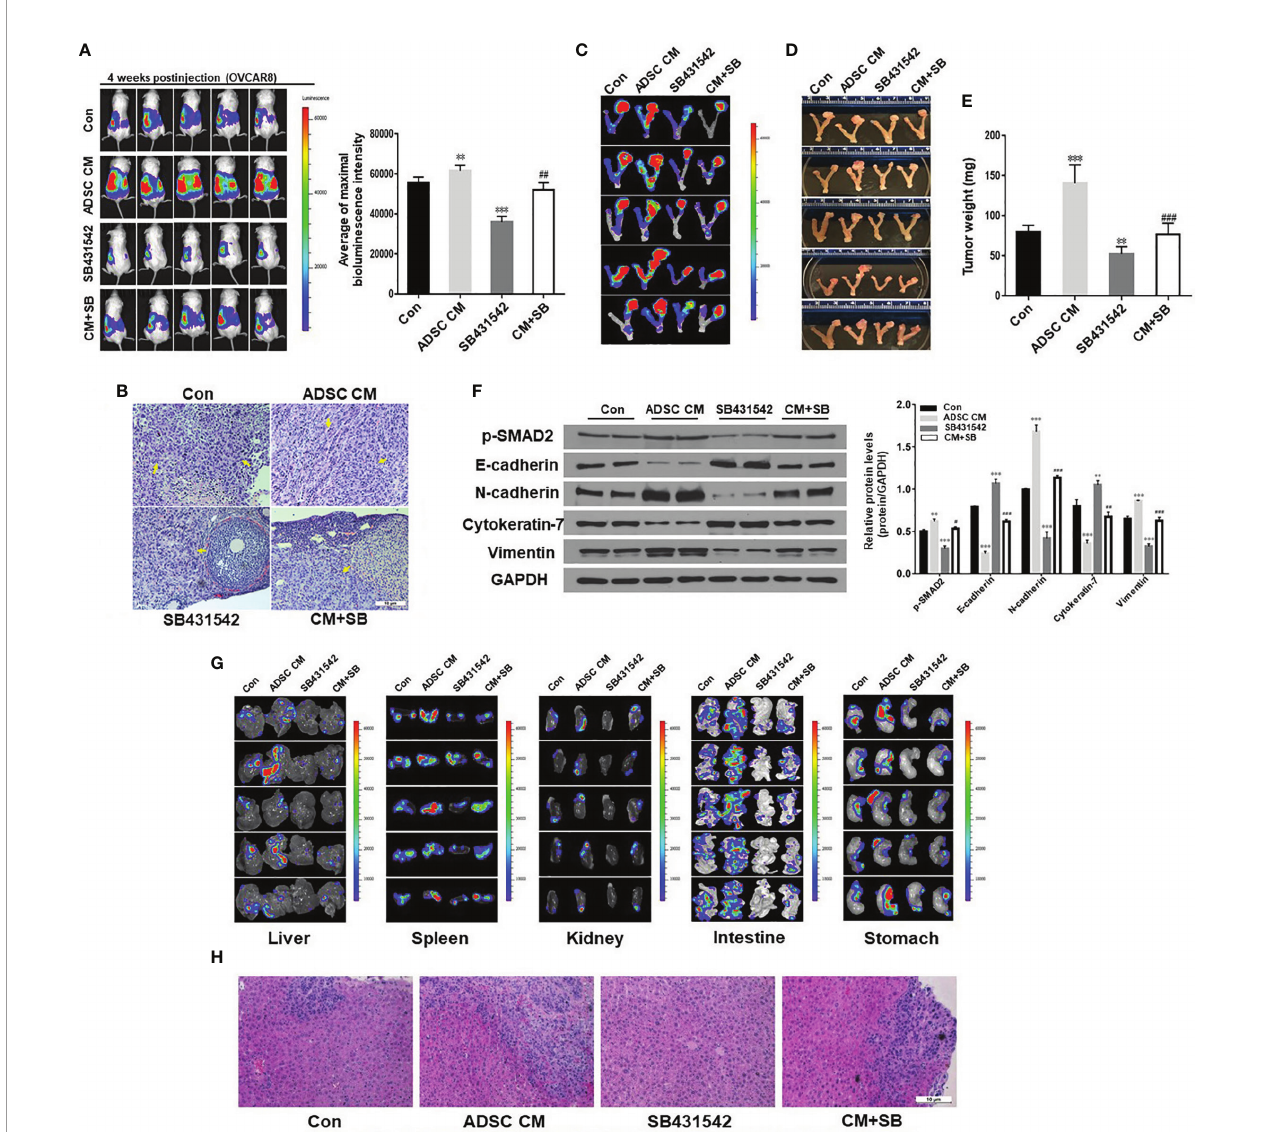
FIGURE 4 | ADSC enhance primary ovarian tumor growth and metastasis in an orthotopic ovarian cancer mouse model. (A) Live animal imaging of primary tumors in ovaries of mice at 4 weeks following intrabursal injection of OVCAR8 cells. Right, the quantitative bioluminescence intensities. (B) H&E staining of primary tumor in ovaries. There are high-grade serous carcinomas involving the ovarian stroma. No normal ovary structure could be seen in the control and ADSC-CM groups. Tumors are indicated by yellow arrows. (C) Primary tumors in ovaries of mice were identi fi ed by live animal imaging. (D, E) Tumors in ovaries of mice were dissected, imaged (D) , and weighed (E) . (F) Western blot analysis of p-SMAD2 and EMT markers in primary ovarian tumors. Right, the quanti fi cation analysis of the blots. (G) Metastatic tumors in liver, spleen, kidney, intestine, and stomach of xenografted mice were identi fi ed by live animal imaging. (H) H&E staining of metastatic tumors in livers of xenografted mice. Data represent the mean ± SD of three independent experiments. ** p < 0.01, *** p < 0.001 compared with the control group. # p < 0.05, ## p < 0.01, ### p < 0.001 compared with the corresponding ADSC-CM